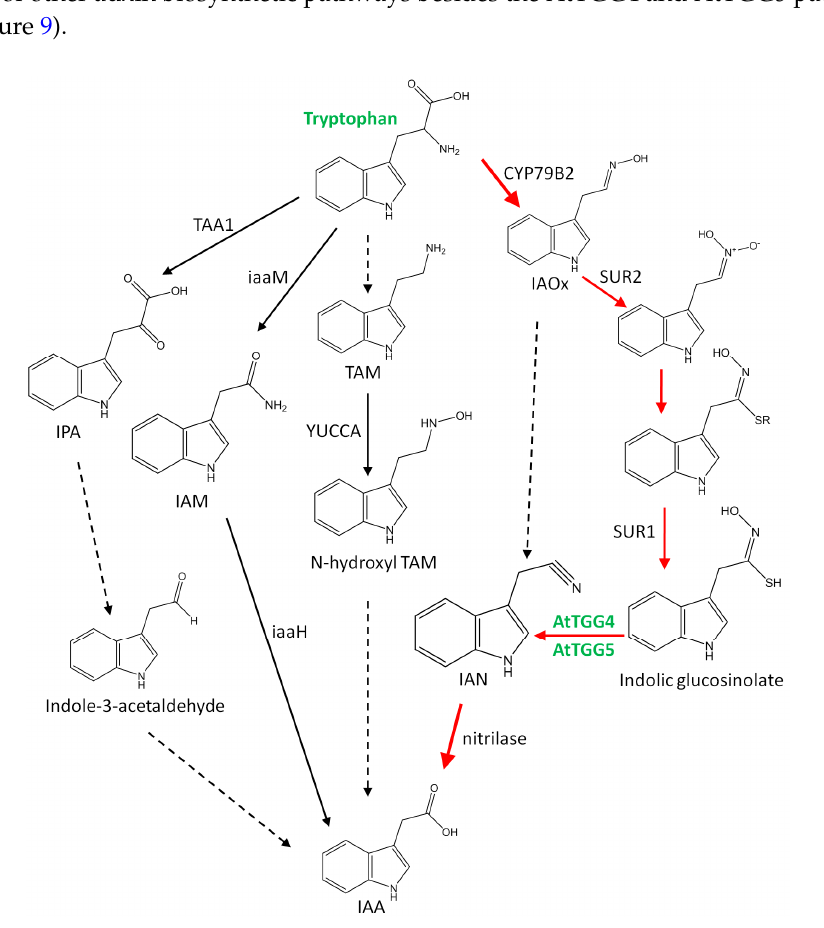
Figure 9. A model of the tryptophan-dependent auxin biosynthetic pathways. Modified from Zhao et al. [43]. The pathway that AtTGG4 and AtTGG5 are involved in is shown in red. Solid arrows indicate that the enzymes catalyzing the steps have been identified; Dashed arrows indicate proposed steps, in which enzymes catalyzing the steps have not been determined conclusively.